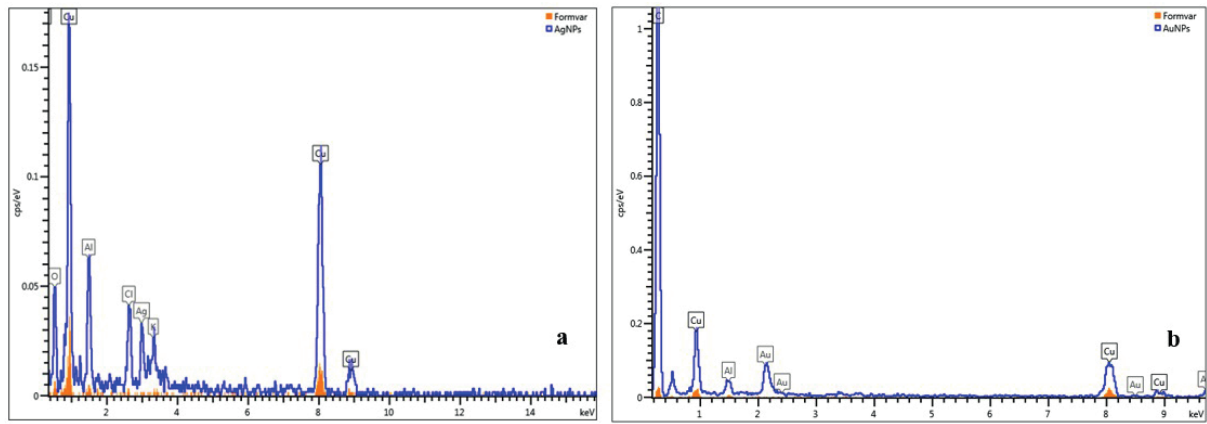
Figure 9. Superimposed EDS spectra obtained for Cu grid with formvar and M_MAE_10_70_AgCl with AgClNPs on Cu grid with formvar (a) and Cu grid with formvar and S_MAE_5_70_Au with AuNPs on Cu grid with formvar (b).